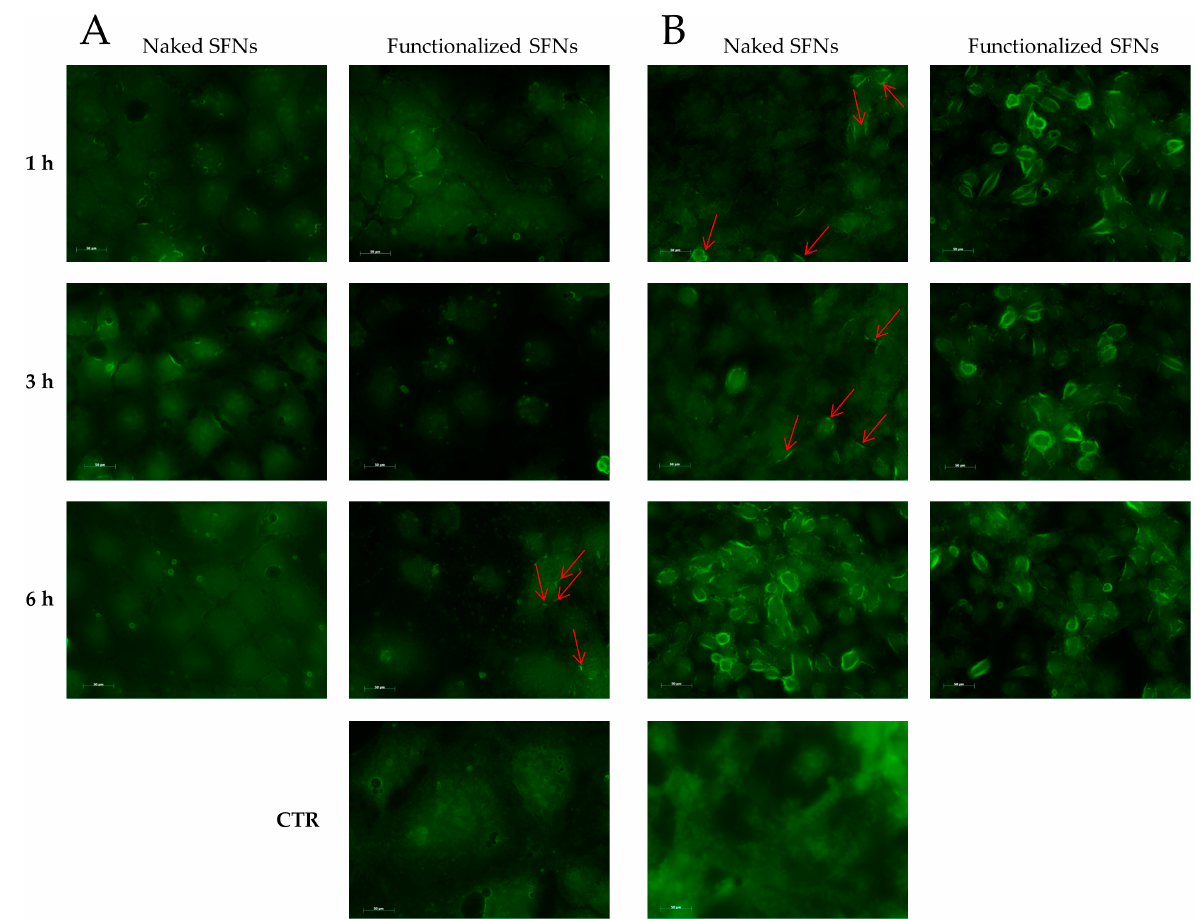
Figure 7. Cellular uptake of naked and functionalized SFNs by Caco-2 ( A ) and ECV ( B ) cells after incubation for 1, 3 and 6 h at 0.01 mg/mL. Red arrows indicate marked fluorescence in the proximity of cell membranes. Scale bar = 50 µm.